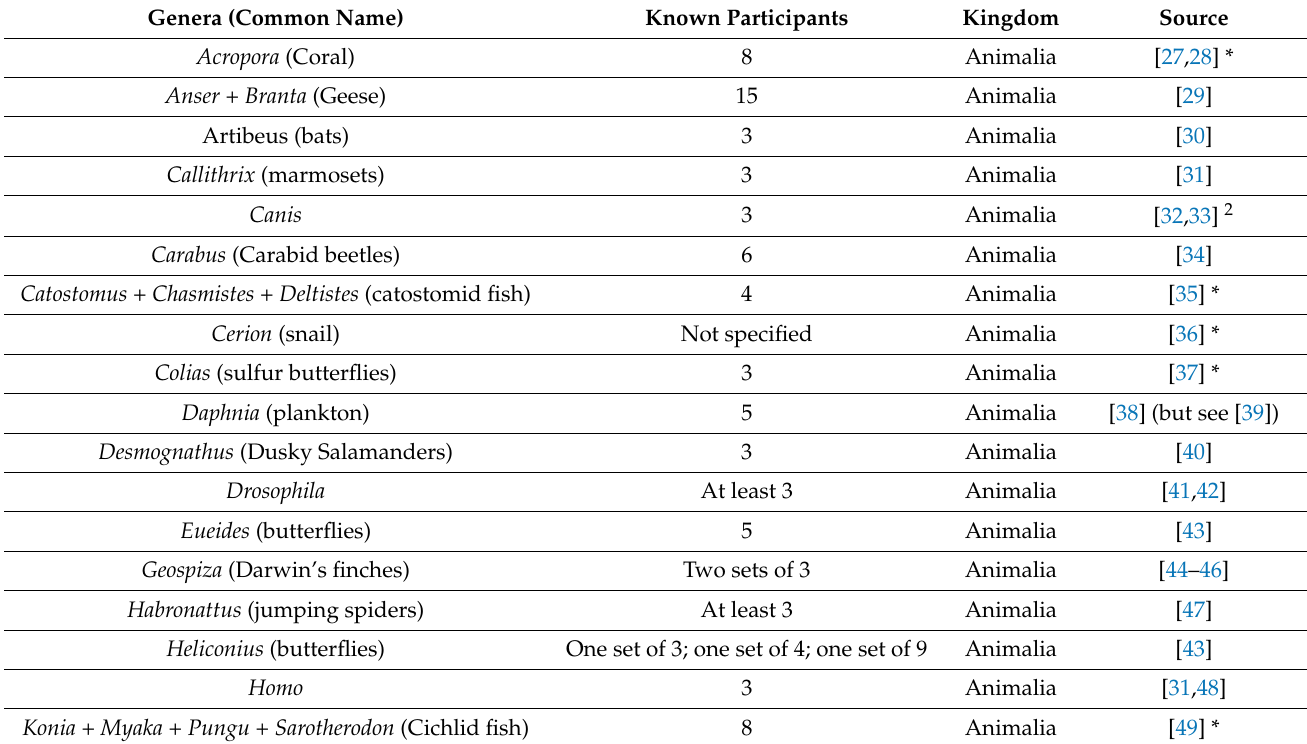
Table 1. Known Syngameons. List of genera with known syngameons and their common names in parentheses. Their number of participants and the taxonomic kingdom they belong to are listed in the following